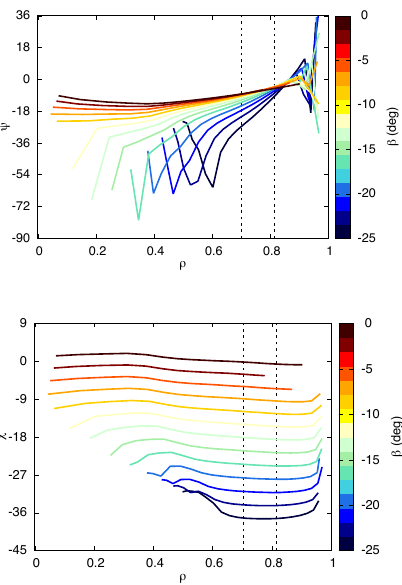
Fig. 9 . (top) y and (bottom) c as functions of the average current density location. Colours refer to different b values. Every point of every line corresponds to a different a value